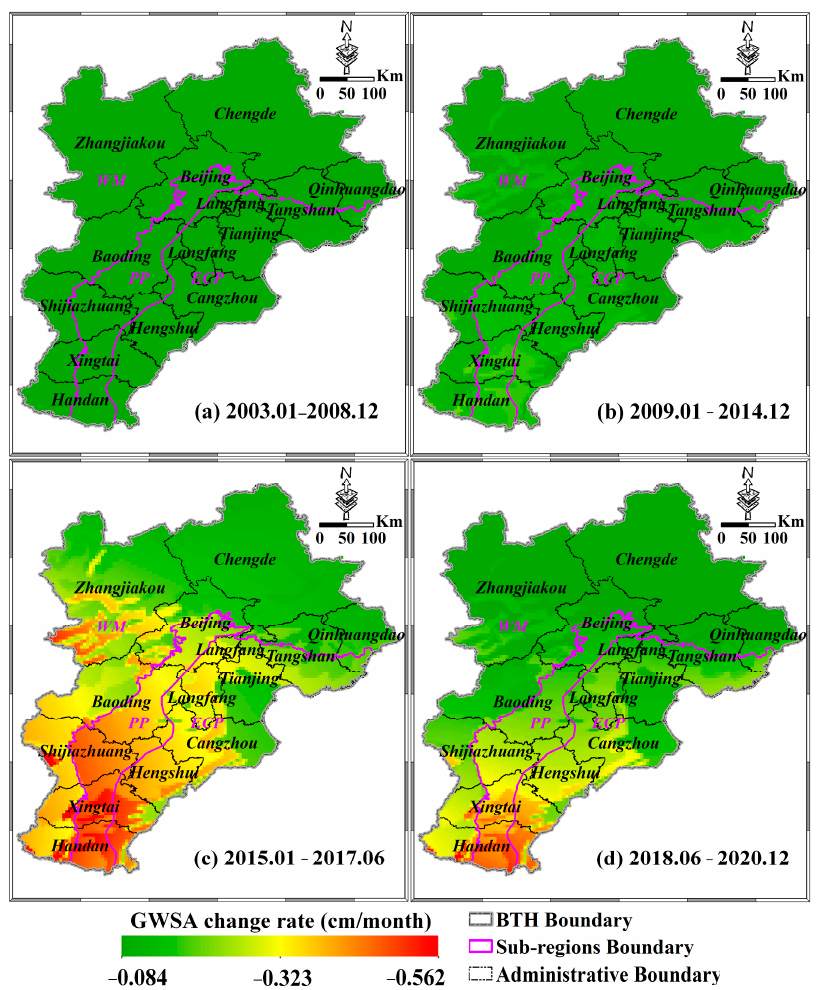
Figure 10. Spatial distribution of GWSA trends in different periods.